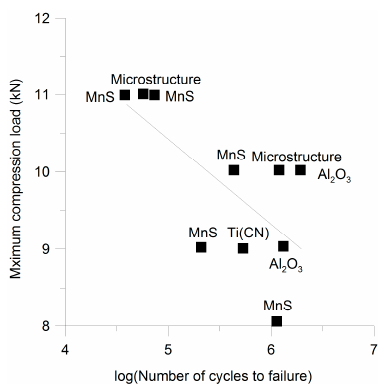
Figure 9. Reasons for fatigue failures in 100Cr6 high strength steel (martensitic bearing steel) after ref. [21].